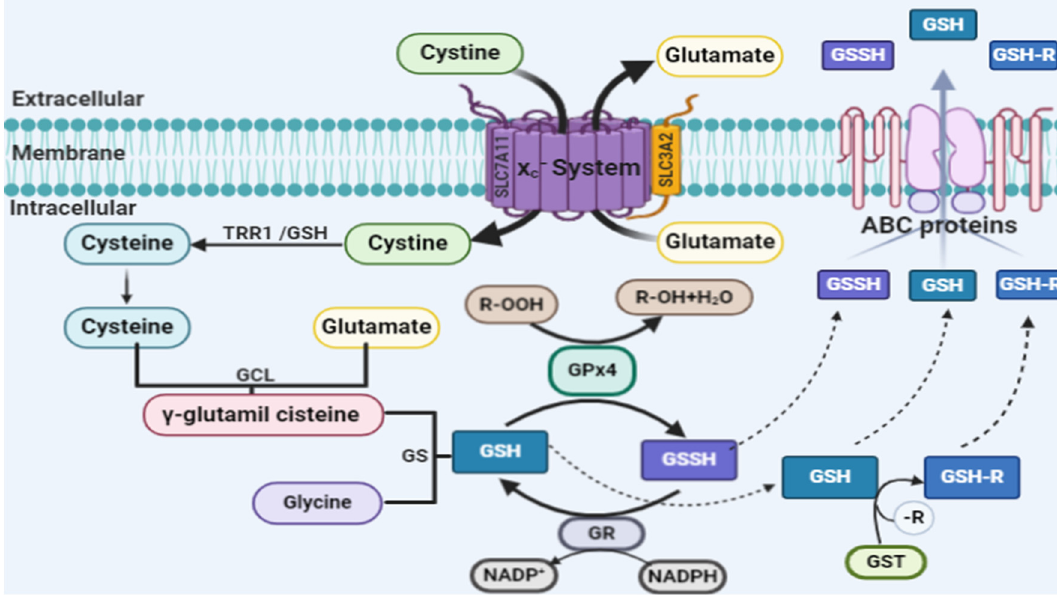
Figure 2. Glutathione (GSH) biosynthesis pathway. GSH is known as one of the small-molecule water-soluble antioxidants, the most important of somatic cells. GSH is a linear tripeptide formed by three amino acids: glutamic acid, cysteine and glycine. The thiol group present in the amino acid cysteine is considered the active site responsible for the antioxidant biochemical properties of glutathione. In biological systems, glutathione can be found in reduced form (GSH) or in oxidized form (GSSG). The oxidized form is a heterodimerization of the reduced form. The GSH / GSSG ratio is used to estimate the redox state of biological systems [51]. The rate-limiting compound of GSH synthesis is the non-essential amino acid cysteine. Cysteine can be imported into cells directly or in its oxidized form, cystine, through the cystine / glutamate antiporter system xc − . In humans, on chromosome 4, the SLC7A11 gene (solute carrier family 7A11) encodes the SLCA11 antiporter, which is part of a system called system xc − . The structure of this protein is heterodimeric and includes two chains: a specific light chain, xCT (SLCA11), and a heavy chain, 4F2hc (SLC3A2), which are linked by a disulfide bridge. The xCT chain has 12 transmembrane domains consisting of 501 amino acids, with the N and C terminal regions located intracellularly; it is not glycosylated and has a molecular mass of approximately 55 kDa. The heavy chain, 4F2hc, is a type II glycoprotein with a single transmembrane domain, an intracellular NH 2 terminal and a molecular weight of approximately 85 kDa. The 4F2hc chain is a subunit common to amino acid transport systems, while the xCT chain is unique to cystine / glutamate exchange. System xc − transports amino acids, independently of sodium and dependent on chloride, which are specific to import cystine and export glutamate at the same time through the plasma membrane. Both amino acids are transported in anionic form. The ratio of counter transport between cystine and glutamate is 1:1. Currently, it is known that system xc − is involved in (a) cystine uptake to maintain the extracellular balance of cysteine / redox cystine, (b) cysteine / cystine uptake for GSH synthesis and (c) non-vesicular glutamate export [68]. Within the cell, cystine is reduced to cysteine. This reduction reaction can be performed by intracellular GSH or by the enzyme thioredoxin reductase 1 (TRR1) [69]. The beginning of GSH synthesis is the formation of the γ -glutamylcysteine molecule, which is catalyzed by the enzyme glutamate cysteine ligase (GCL). GCL catalyzes the binding of glutamate and cysteine in the presence of adenosine triphosphate (ATP). Then, the enzyme GSH synthase (GS) catalyzes the formation of GSH through the link between γ -glutamylcysteine and glycine [69]. GSH reduces radicals (R • ) non-enzymatically and organic hydroperoxides catalyzed by GSH peroxidase (GPx) and is thus converted to GSH disulfide (GSSG). GSSG is recycled to GSH by GSH reductase (GR), a reaction that uses reduced nicotinamide adenine dinucleotide phosphate (NADPH) as a cofactor [69]. GSH S-transferase (GST) forms GSH (GS-R) adducts from organic molecules (R) and GSH, which together with GSH and GSSG are exported from the cell by ABC transporters, mainly ABC-1 and ABC-G2 [70,71]. Extracellular GSH is metabolized by the γ -glutamyl transferase (GGT) ectoenzyme, which transfers the γ -glutamyl residue to different acceptor amino acids, leading to the formation of a dipeptide containing γ -glutamyl and the cysteine